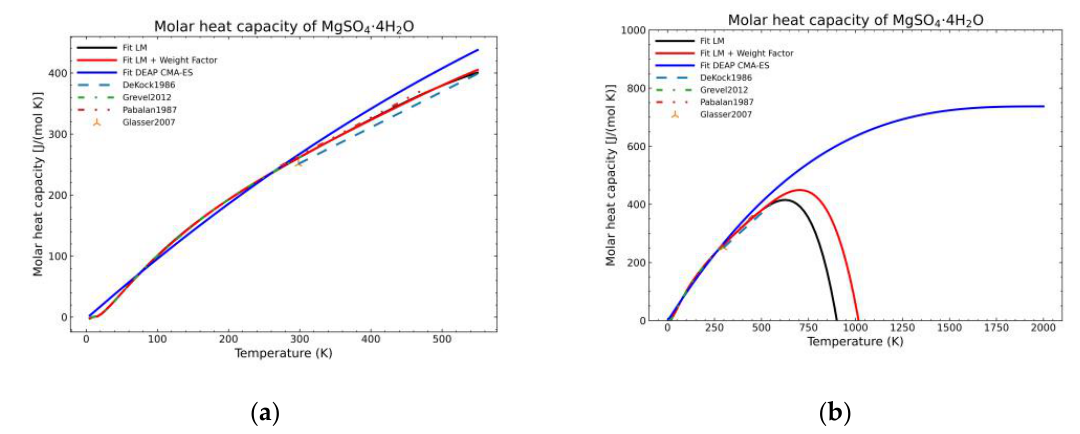
Figure 7. Comparison of the different fit results of MgSO 4 · 2H 2 O showing: ( a ) literature points region; ( b ) extended range until 2000 K.